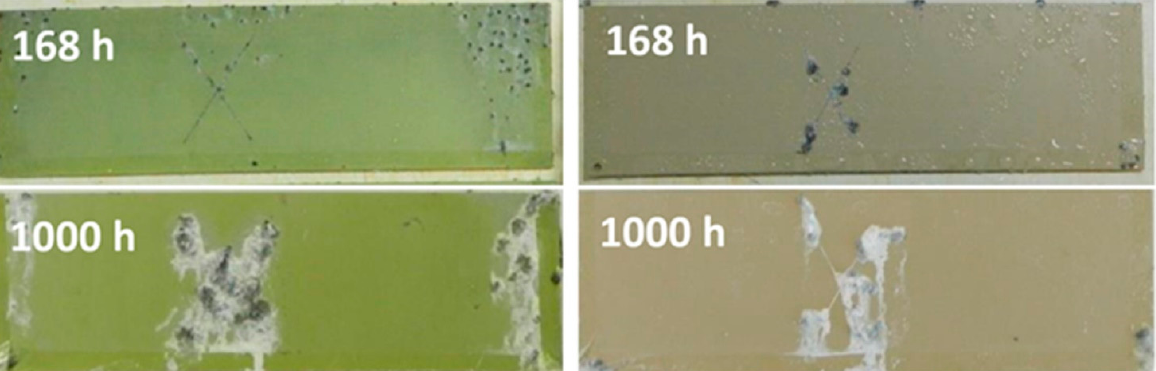
Figure 19. NSST results for full systems protection with scribed defect (in the form of a cross in the center): (left side) CCC/chromated primer system; (right side) inhibitor loaded PEO coating with chromate-free primer (SiPF/4MSA/primer) [136].